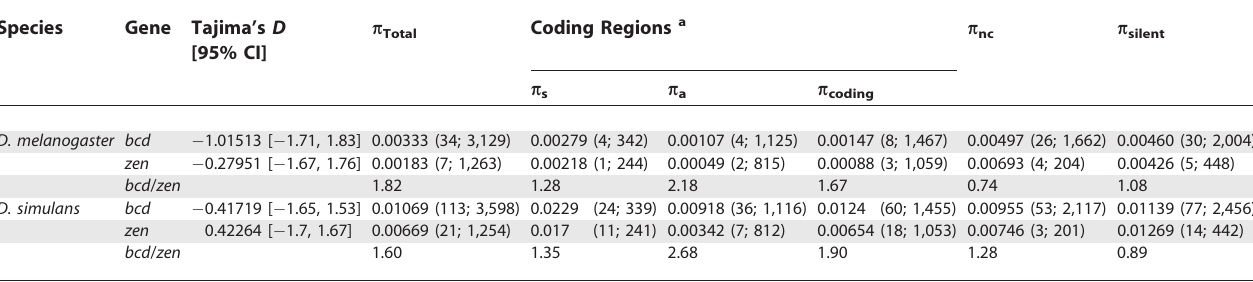
Table 1. Tajima’s D and Nucleotide Diversities ( p ) for bcd and zen Species Gene Tajima’s D [95%